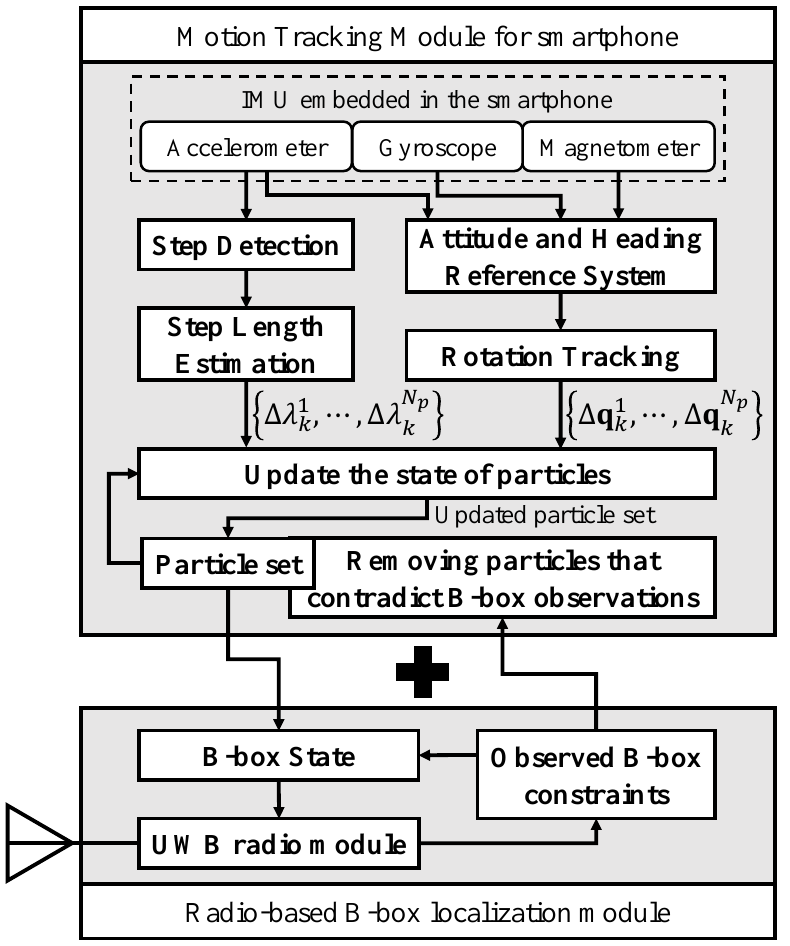
Figure 1. Impulse-Response Ultra-WideBand (IR-UWB)-based cooperative multi-hop self-localization